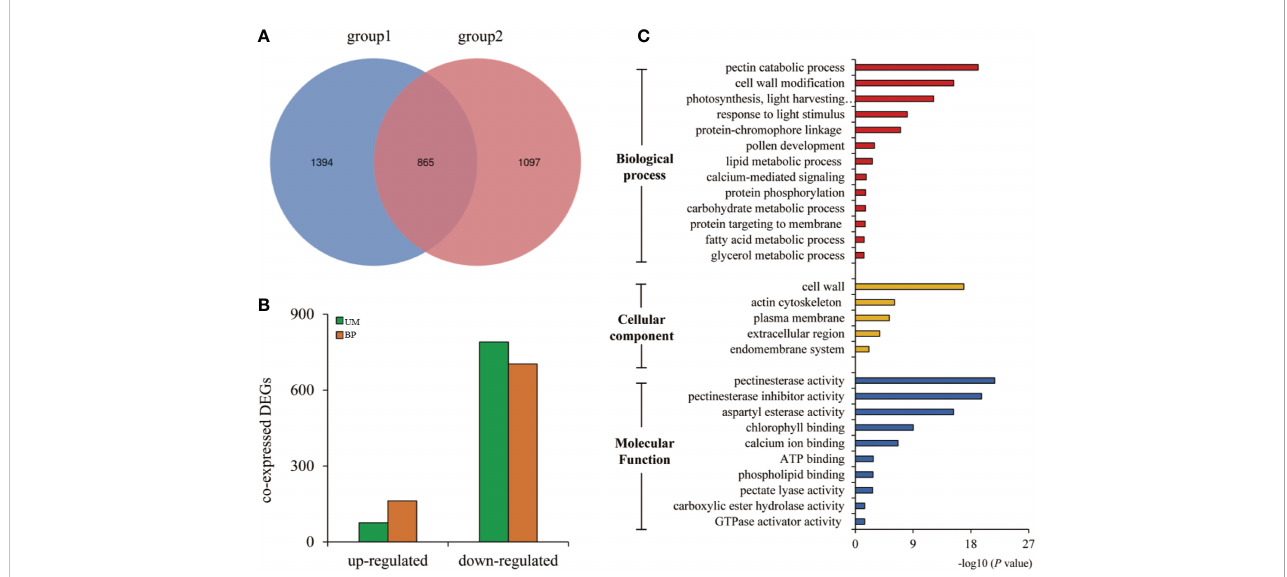
FIGURE 2 Analysis of differentially expressed genes (DEGs) in W931A at the uninucleate microspore (UM) and binucleate pollen (BP) stages. (A) Venn diagram showing the number of unique and overlapping DEGs at the UM stage (group1) and the BP stage (group2). (B) Number of up-regulated and down- regulated genes at the UM and BP stages, respectively. (C) Most highly enriched Gene Ontology (GO) terms among the DEGs.